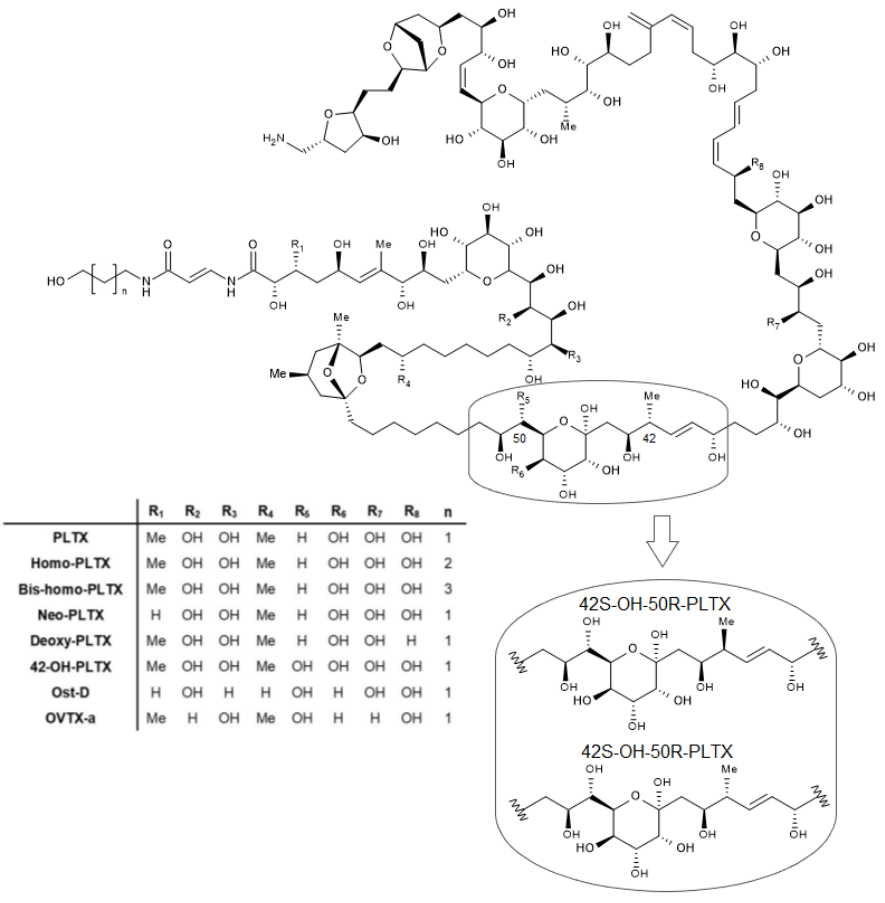
Figure 1. Structure of palytoxin and its analogues.